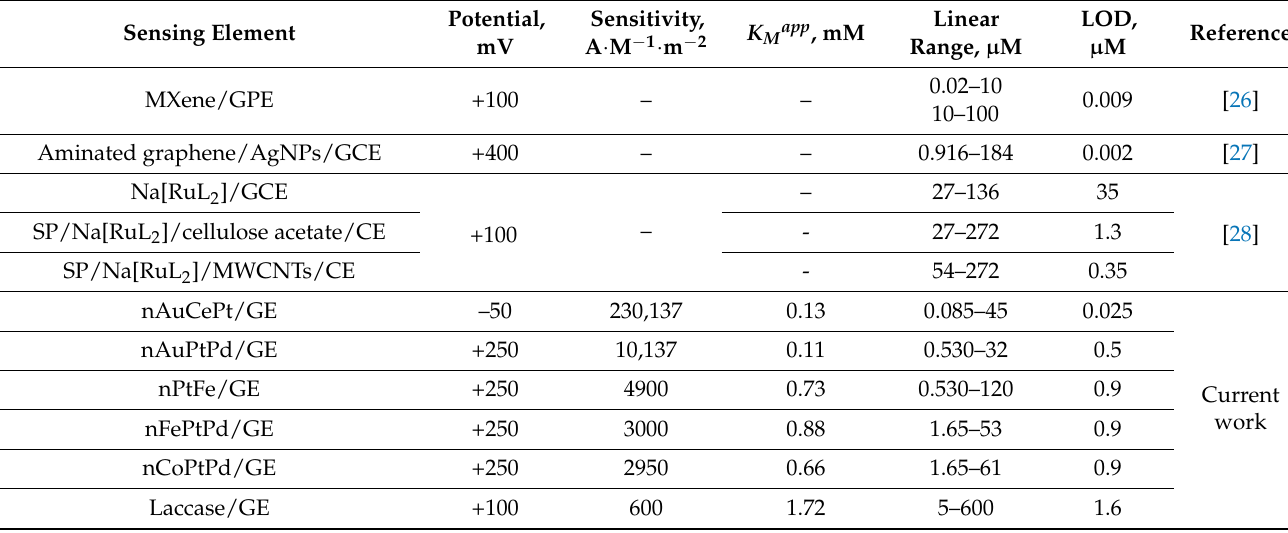
Figure 3. Characteristics of nAuCePt/GE: CV as current responses upon AD addition up to 0 mM (1, black line), 4 µM (2, red line), 8 µM (3, blue line), and 16 mM (4, green line) concentrations ( a ); chronamperometric response ( b ), dependence of amperometric signal on concentration of AD ( c ) and calibration graph ( d ) under working potential − 50 mV.